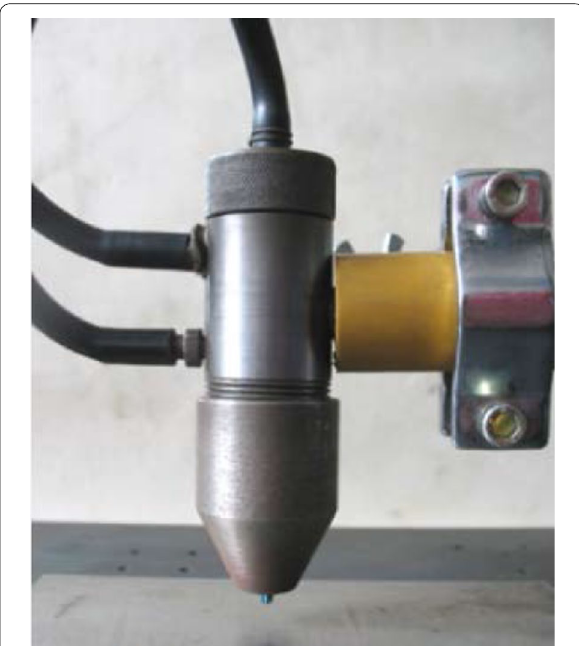
Figure 3 GPCA‑TIG welding torch